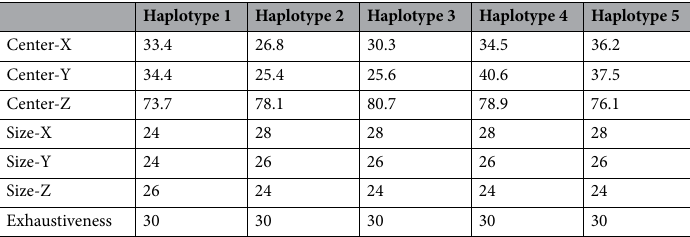
Table 1. Docking grid box dimensions used for each haplotype.